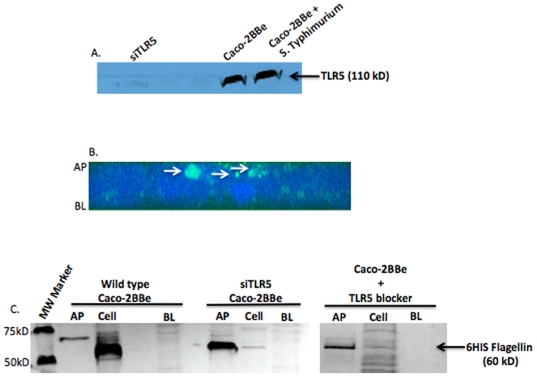
Flagellin was not internalized by siTLR5 Caco-2BBe cells or IEC in which TLR5 was blocked.
A. Immunoblotting for TLR5 via Western blot showed that TLR5 expression is dramatically reduced in siTLR5 Caco-2BBe cells compared to wild type Caco-2BBe cells. Further, wild type Caco-2BBe cells infected with S. Typhimurium (MOI 500) did not change the expression of TLR5 2 h post-infection. B. Transverse image of polarized siTLR5 Caco-2BBe cells constructed from optical z-stacks taken by confocal microscopy, showing flagellin (green) was localized to the AP surface at thirty minutes post-exposure. Cell nuclei were stained with DAPI (blue). C. The majority of flagellin remained on the apical surface of siTLR5 Caco-2BBe cells and wild type Caco-2BBe cells pre-treated with TLR5 blocker antibody following 1 h incubation with 5 µg of flagellin. Whereas, the predominant quantity of flagellin was found in the cell layer of wild type Caco-2BBe controls. Flagellin was not detected in the BL supernatants of any of the tested cell samples. These results represent 1 of 3 repeated experiments with similar results.